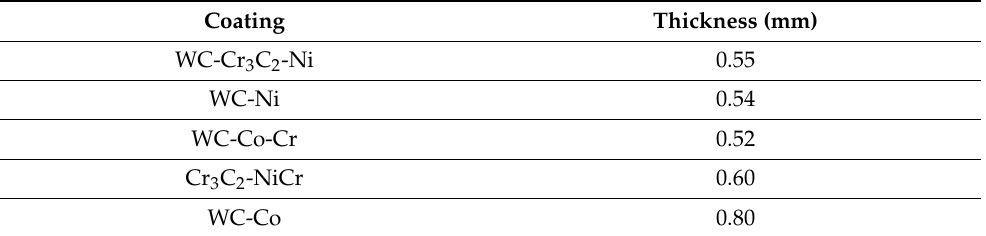
Table 2. Coatings